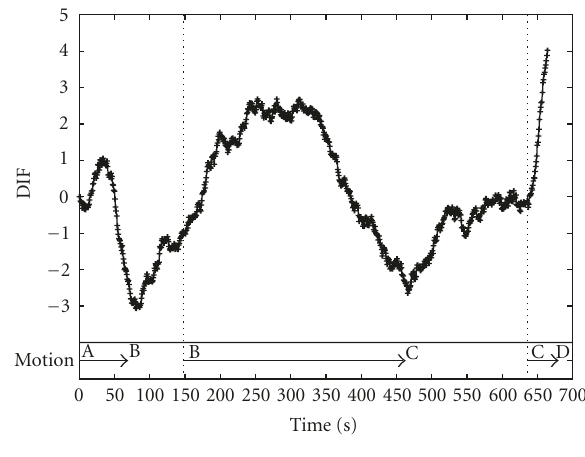
Figure 18: Variation of DIF value obtained by the MT in WMAN.